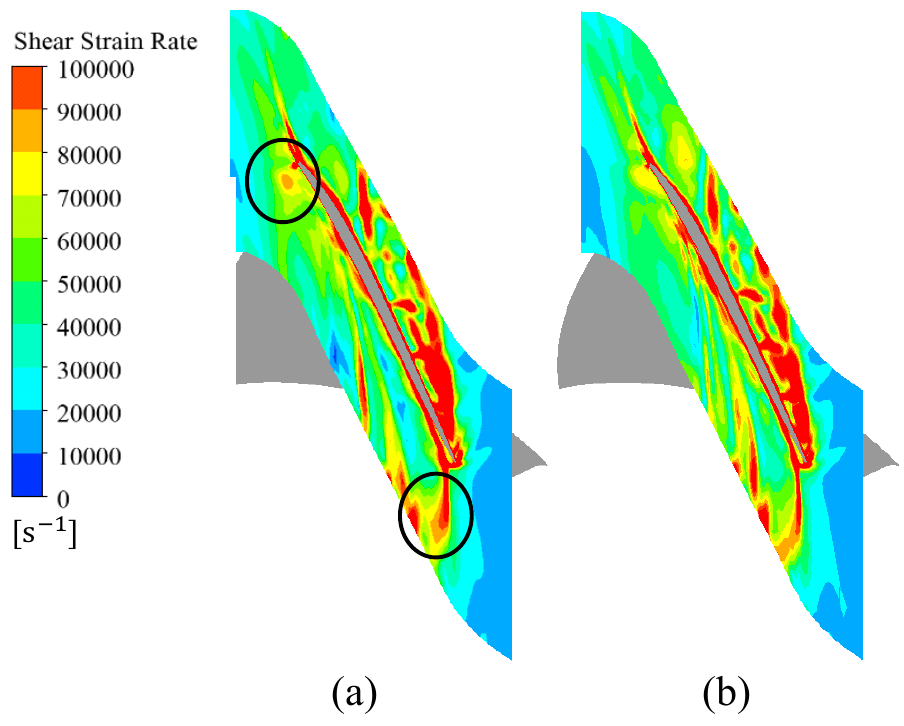
Figure 12. Contours of shear strain rate at 98% span. ( a ) SES; ( b ) CCT.